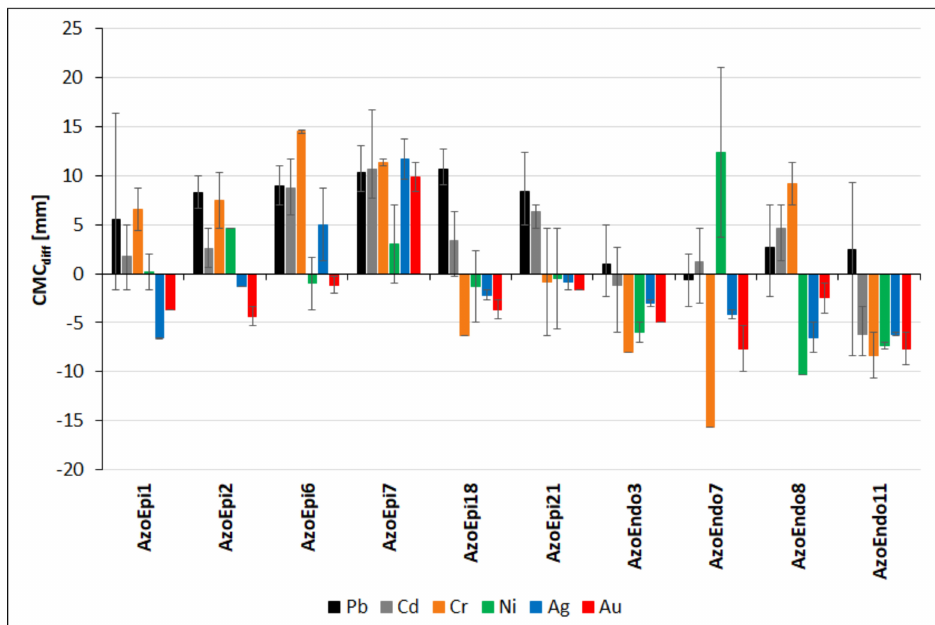
Figure 6. Effect of the metals applied in the specified range of doses (in mg L − 1 ) on the cellulolytic activities of the selected strains expressed as differences in the size of halos (in mm) vs. the untreated control. Positive values of bars—stimulation of the activity; negative values of bars—inhibition of the activity. Positive whisker—maximum difference; negative—minimum. See Table 1 for strain